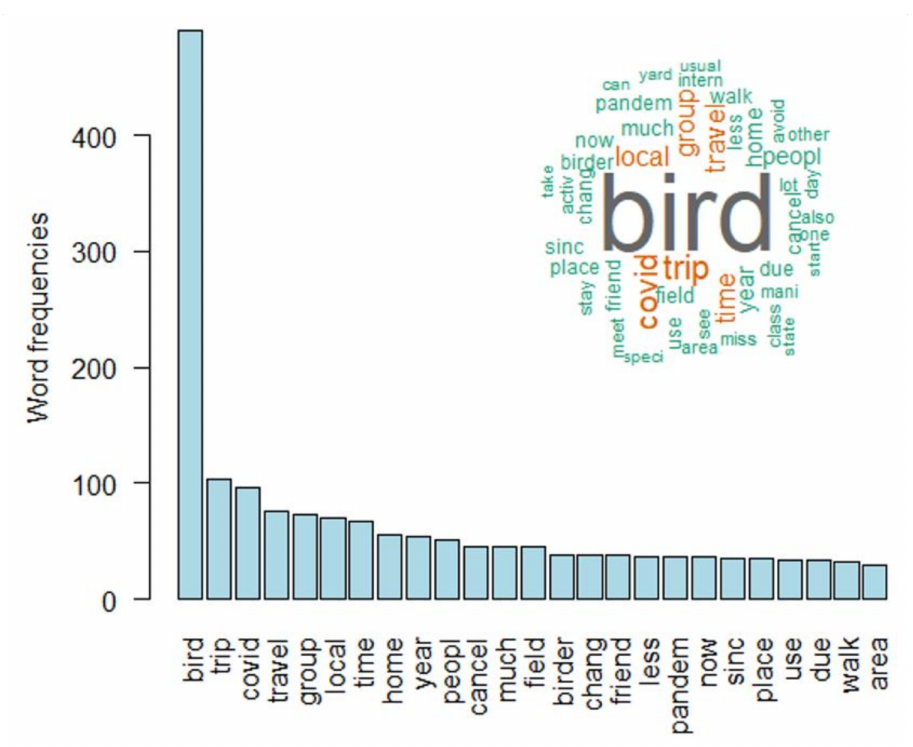
Figure 1. The bar plot illustrates the 25 most frequent words used in 2020 whereas the word cloud illustrates all words with a minimum frequency of 75.